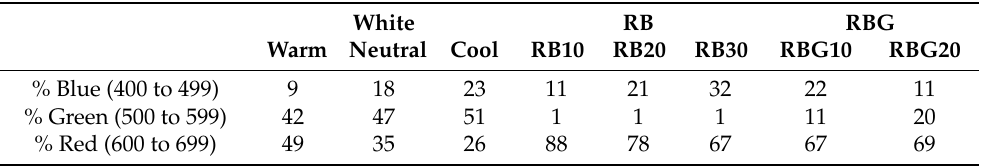
Table 1. Representative ratios of blue, green and red fluxes as a percentage of photosynthetic photon flux density (PPFD). Values from the three species and two intensities deviated less than 10% from the average and thus we present average values. RB refers to treatments comprised of red and blue LEDs and RBG refers to treatments comprised of red, blue and green LEDs. White RB RBG Warm Neutral Cool RB10 RB20 RB30 RBG10 RBG20 % Blue (400 to 499) 9 18 23 11 21 32 22 11 % Green (500 to 599) 42 47 51 1 1 1 11 20 % Red (600 to 699) 49 35 26 88 78 67 67